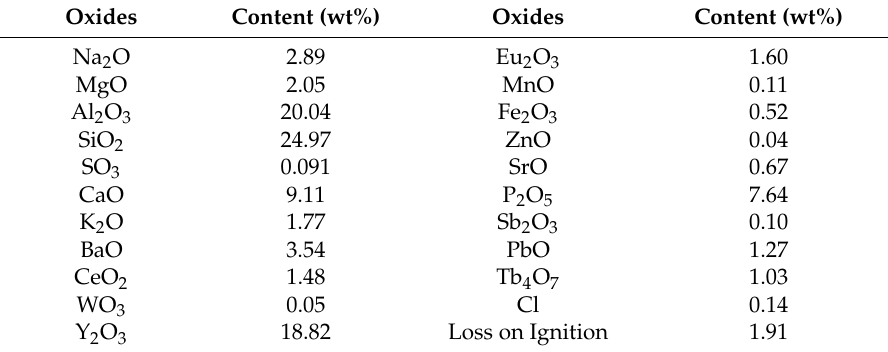
Table 1. Chemical composition of actual waste